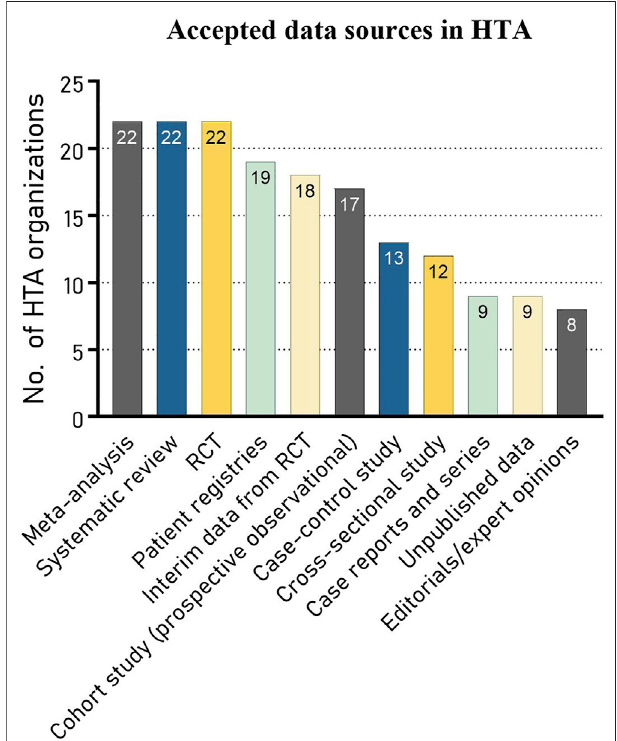
FIGURE 1 | Different data sources accepted by HTA organizations (N =